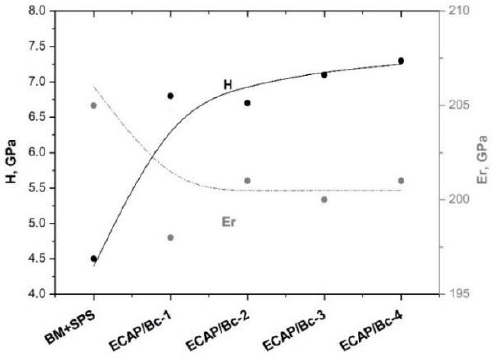
Figure 4. Nanoindentation hardness, H , and reduced elastic modulus, E r , vs. BM + SPS, and vs. cumulative ECAP-B C straining, after BM + SPS.